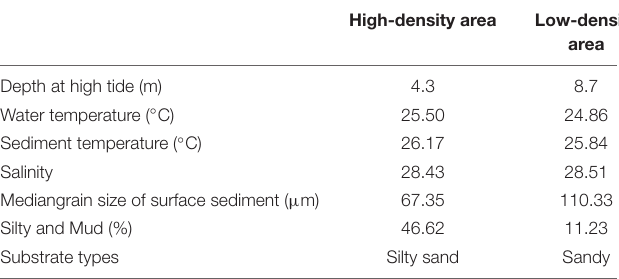
TABLE 1 | Environmental characteristics of the sampling